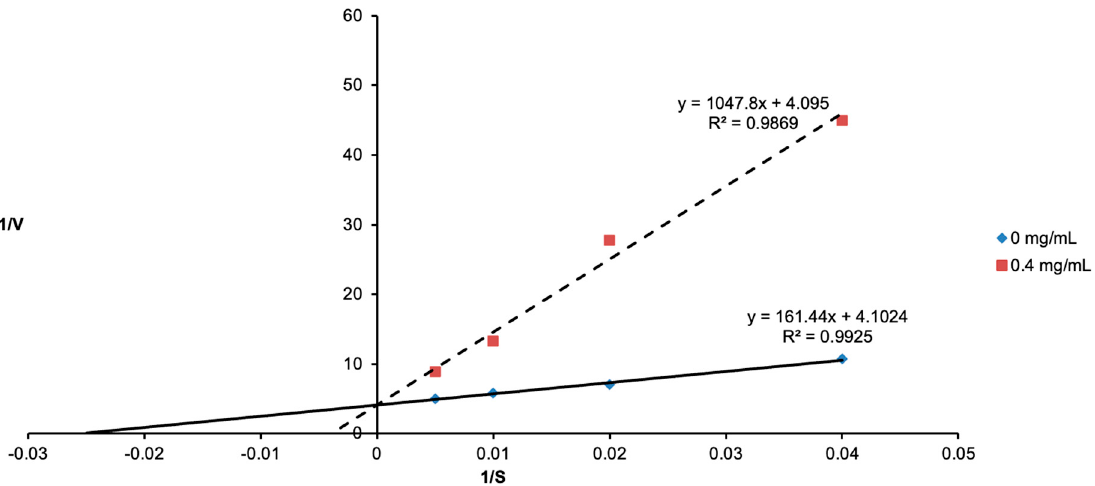
Figure 4. Lineweaver-Burk plot of conversion of L-DOPA to dopachrome by tyrosinase in the presence and absence of quercetin.